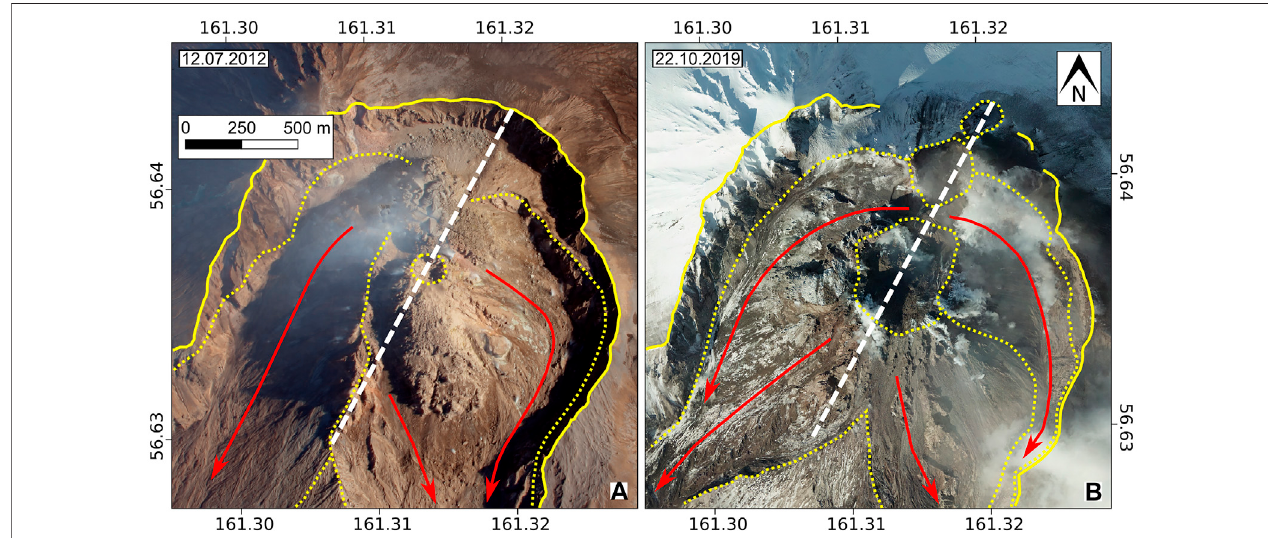
FIGURE 12 | SW – NE lineament in relation to the Shiveluch dome ’ s features. The lineament is shown as the white dashed line. The yellow line outlines the collapse amphitheater, and the dotted lines outline the features (craters and collapse scars). The red arrows show the directions of partial dome collapses. The base images are aerial